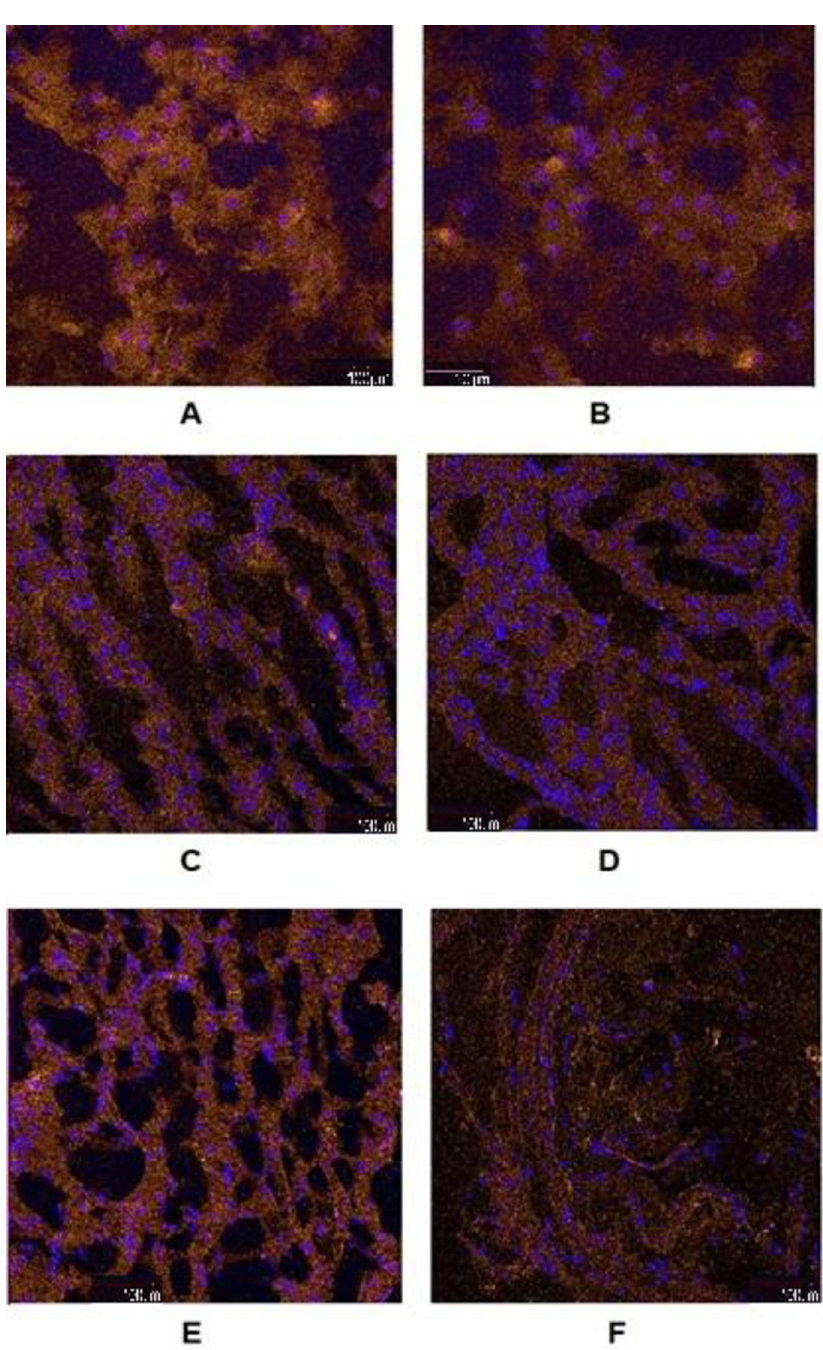
Fig 3. Immunofluorescent staining with antibodies to serotonin (orange fluorescence), Hoechst nuclear stain (blue fluorescence), х 400. A—Serotonin expression in the medulla of infants in the control group, B—Serotonin expression in the cardiac tissue of infants with SIDS, C—Serotonin expression in the cardiac tissue of infants in the control group, D—Serotonin expression in the cardiac tissue of infants with SIDS, E—Serotonin expression in the aorta of infants in the control group, F—Serotonin expression in the aorta of infants with SIDS.